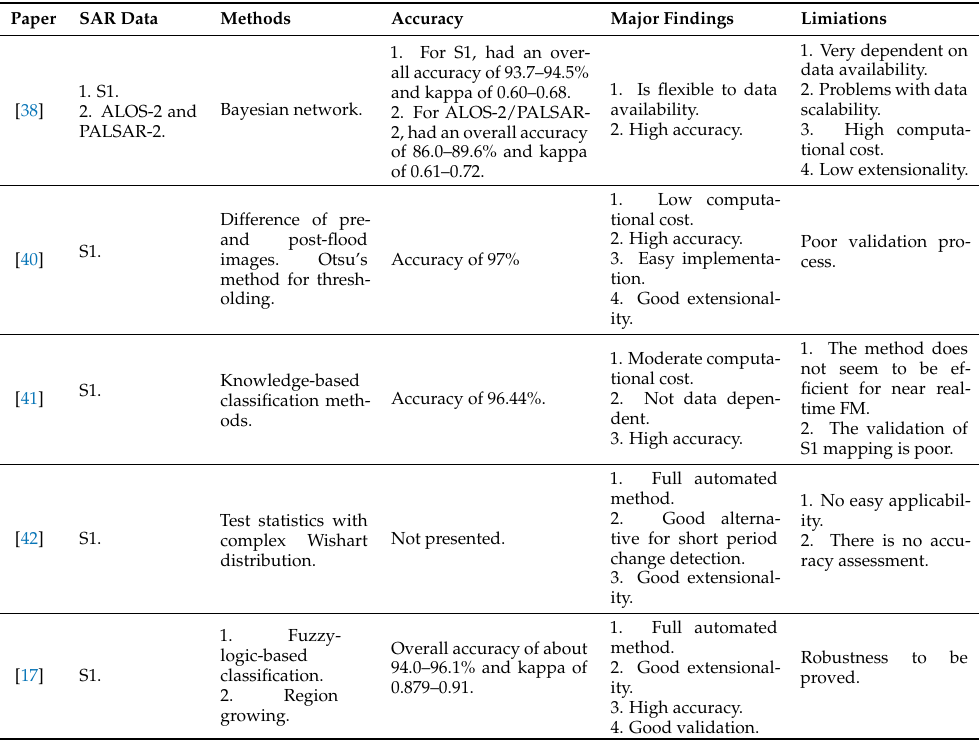
Table 1. Examples of papers about FM using SAR